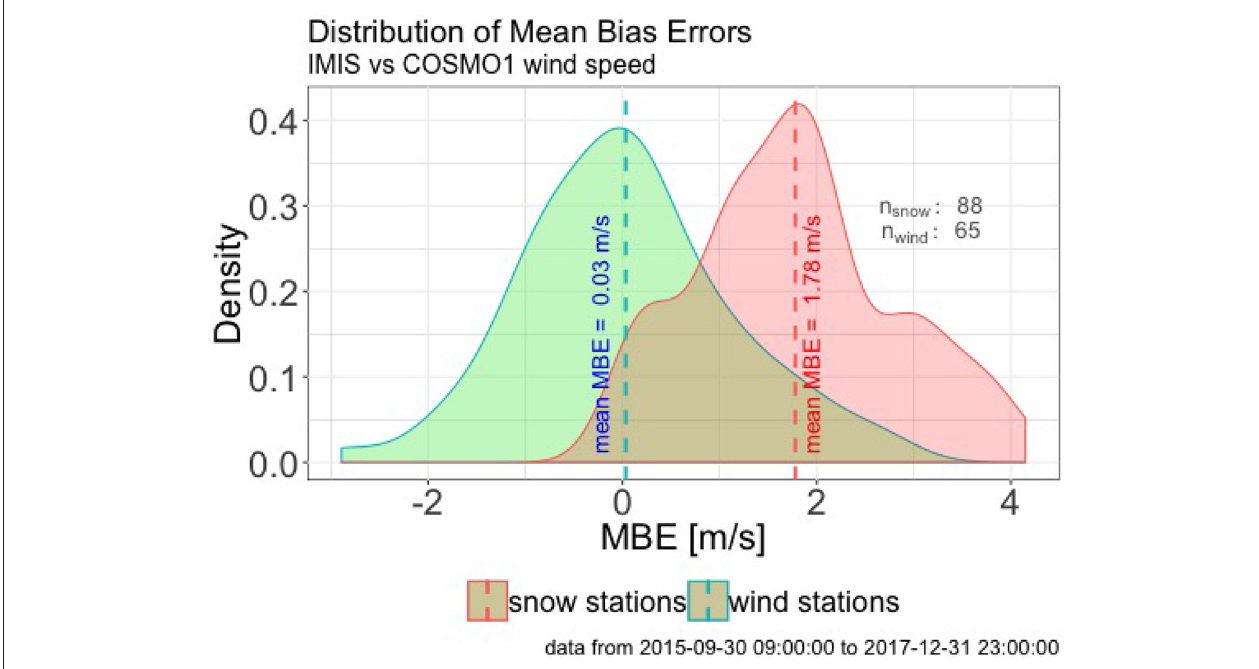
FIGURE 4 | Mean Bias Error (MBE) between IMIS and COSMO-1 wind speeds. The plot shows the distribution of the individual MBE’s, that were calculated as the MBE between each station’s observed (measured) time series and the time series of the corresponding COSMO-1 grid cell.